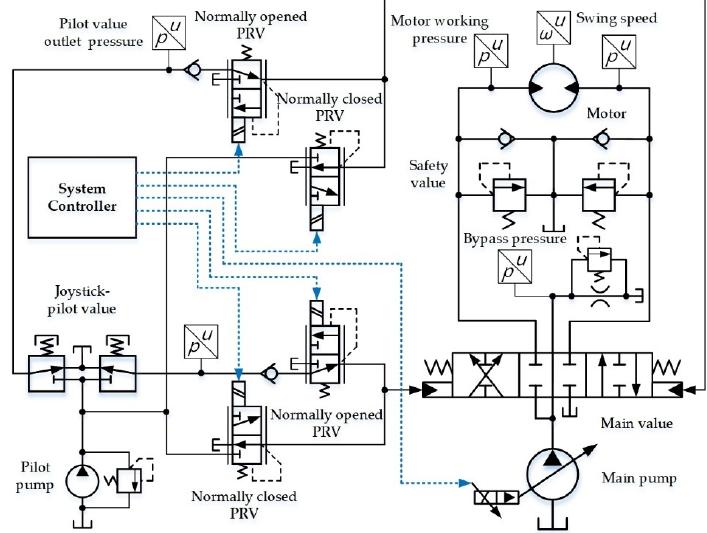
Figure 2. Hydraulic schematic of electro-hydraulic negative control swing